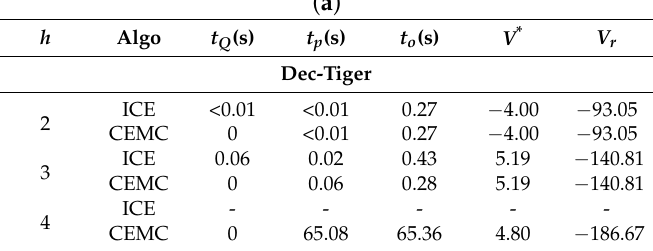
Table 1. Comparable results of some